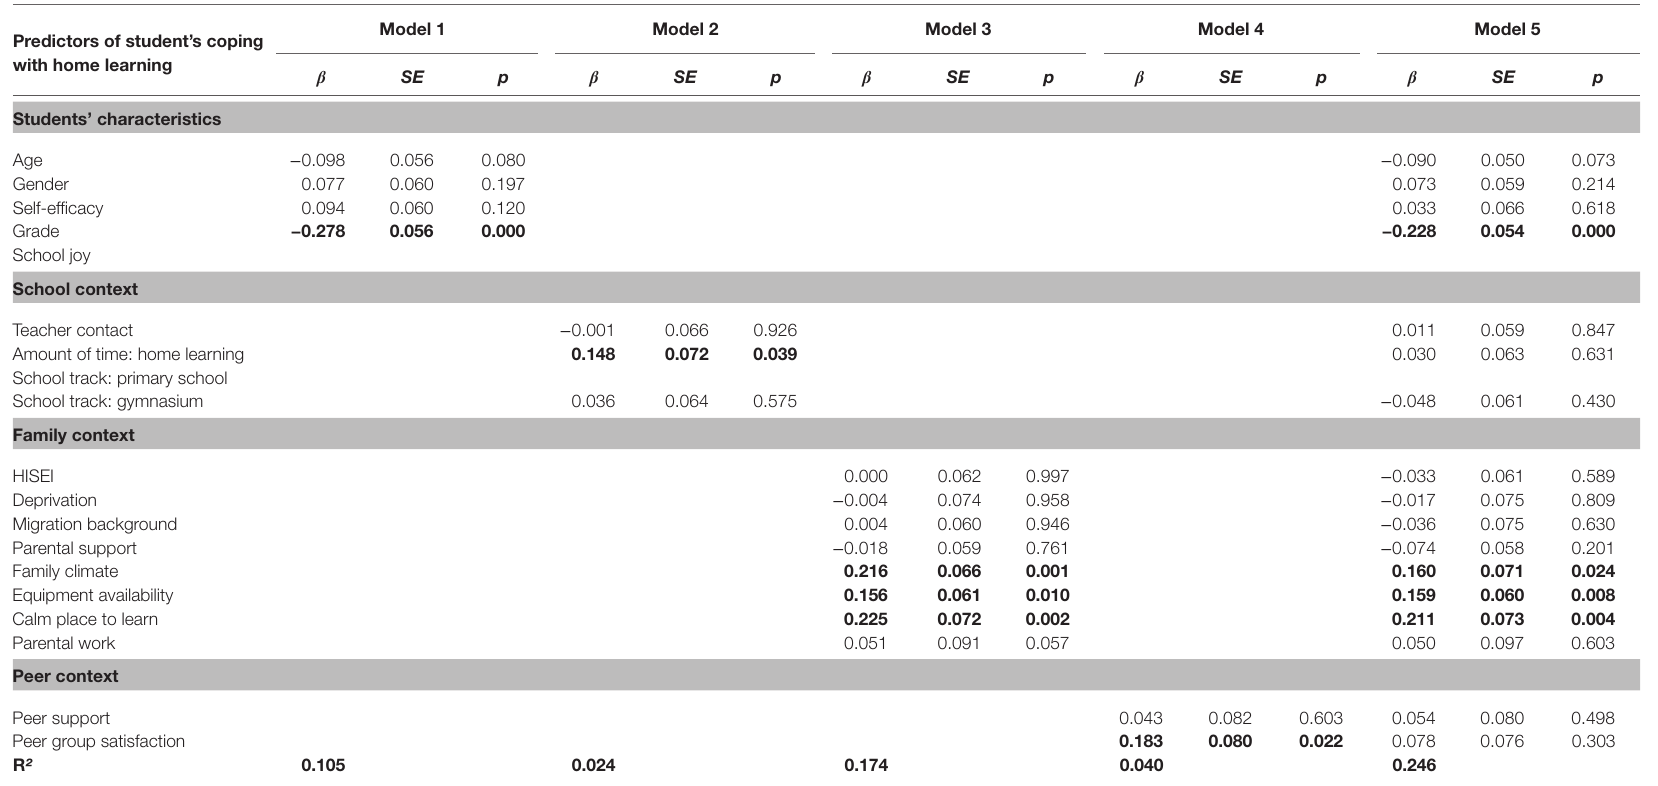
TABLE 3 | Individual and contextual predictors of adolescents’ self-perceived coping success with home learning. Predictors of student’s coping with home